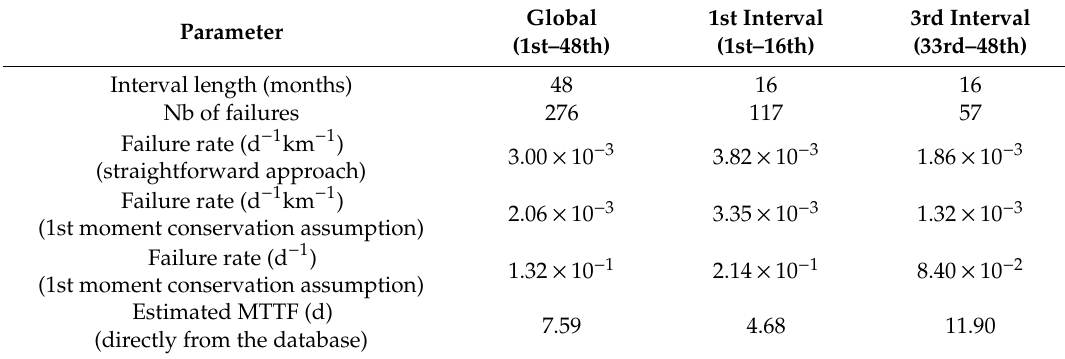
Figure 10. The third interval of 16 months ( Table 2. Comparison between the straightforward estimations and the first moment conservation. Parameter